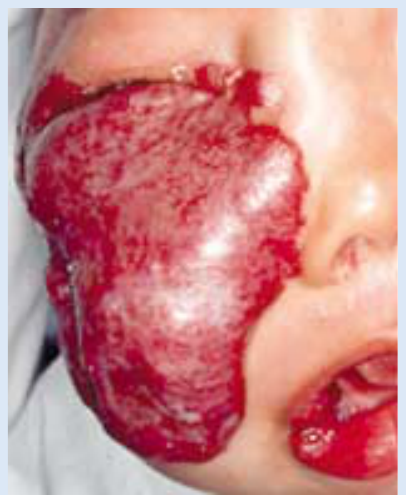
Fig. 1b. Large maxillary and periorbital cutaneous haemangioma. Its anatomical position threatens the function of the